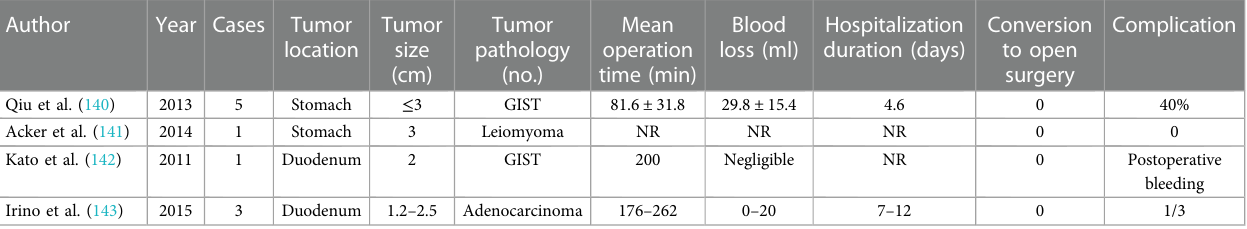
TABLE 7 Research studies of the LAES technique.